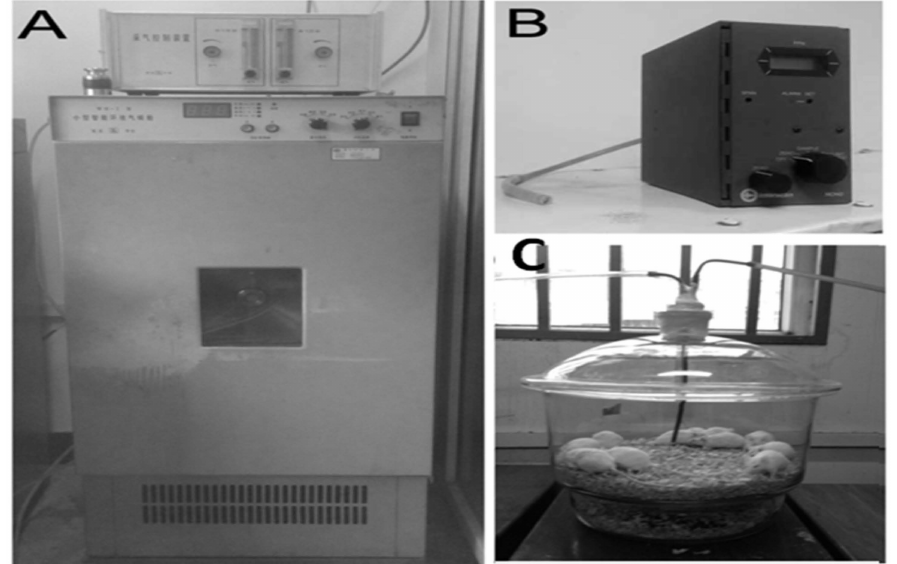
Figure 1. Mice inhale gaseous FA under a simulated occupational FA exposure environment. ( A ) An intelligentized environmental chamber for generating gaseous FA at 3.0 mg/m 3 ; ( B ) An interscan 4160 digital electrochemical analyzer for detecting gaseous FA concentrations; ( C ) A modified 8.4 L of glass inhalation chamber for mimicking occupational FA exposure